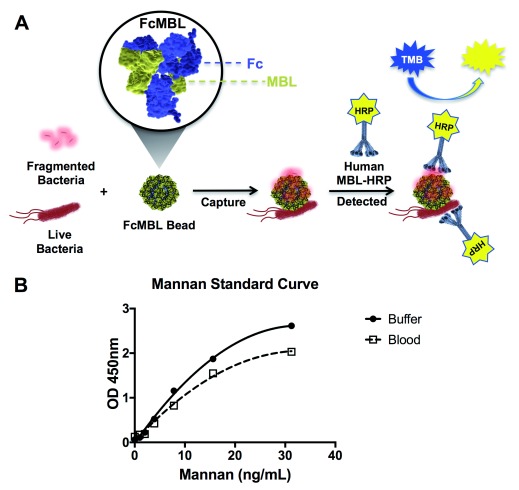
FcMBL ELLecSA.(
A) Diagrammatic representation of the FcMBL ELLecSA methodology. Live and fragmented bacteria are captured by FcMBL, which has been coated on superparamagnetic beads via an N-terminal aminooxy-biotin on the Fc to allow oriented attachment to streptavidin (FcMBL Bead). FcMBL beads with captured bacteria are then magnetically separated and detected using recombinant human MBL linked to horseradish peroxidase (Human MBL-HRP). Tetramethylbenzidine (TMB) substrate is added to quantify captured bacteria and results are read at OD 450nm. (
B) Mannan standard curve showing FcMBL binding to mannan in buffer and spiked into whole human blood (<24 h from draw), measured at optical density 450 nm. The mannan standard curve in buffer serves as an internal assay control, and is used to determine FcMBL binding to pathogen material in units of PAMPs/ml (where 1 ng/ml of mannan bound by FcMBL is equivalent to 1 PAMP unit. PAMP units are then multiplied by the dilution factor of the sample volume to give PAMPs/ml).